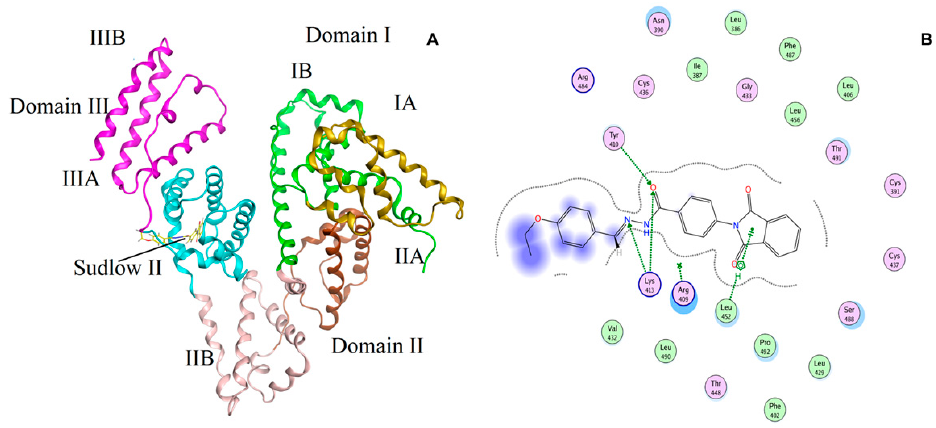
Figure 7. ( A ) The docking conformation of 6P -BSA complex with lowest energy; ( B ) The amino acid residues surrounding 6P .